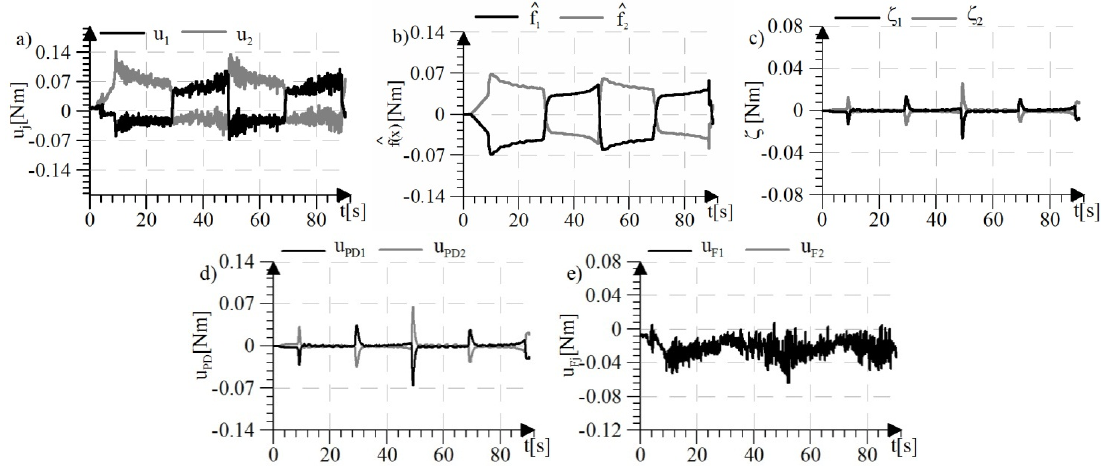
Figure 10: Control signals for links 1 and 2: a) the overall control, b) the compensatory control, c) the robust control, d) the PD control, e) the force